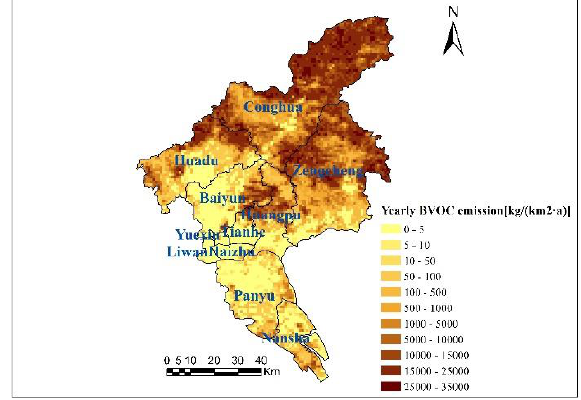
Figure 3. Spatial distribution of the total biogenic